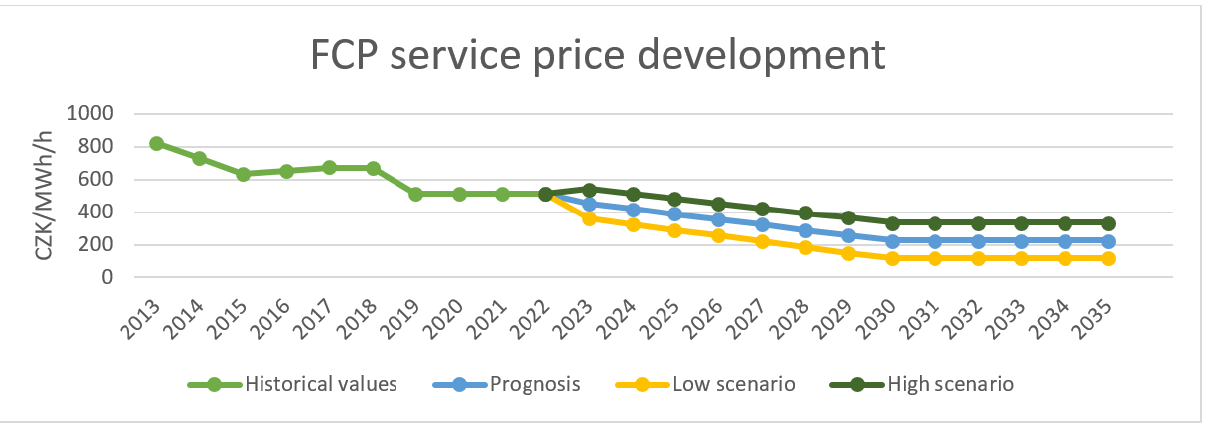
Figure 6. FCP service price development [32].